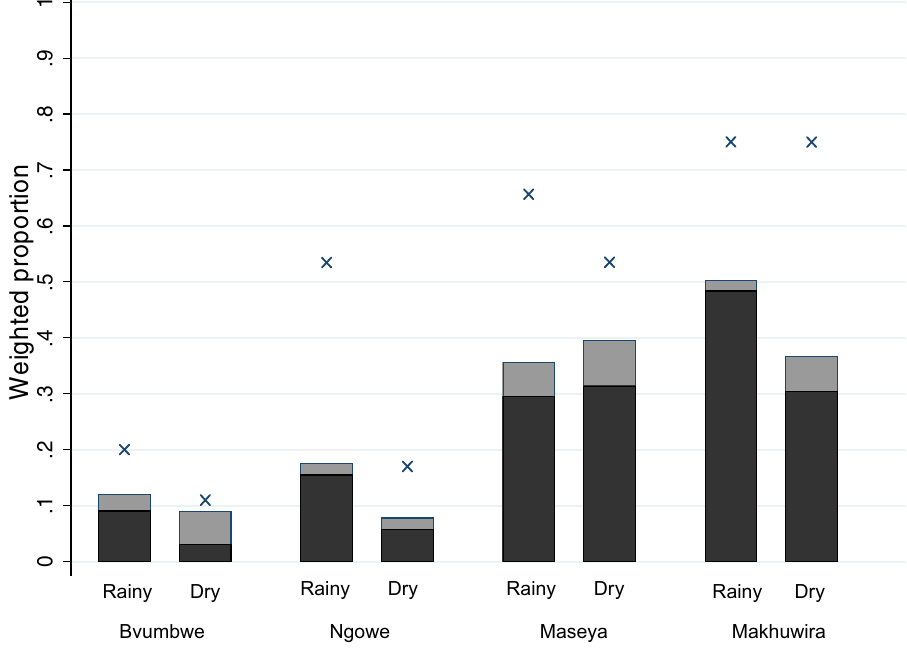
Figure 1. Baseline weighted proportion of students with P. falciparum infection detected by PCR (×) and the weighted proportion of students with gametocyte-containing infections detected (black bar) and not detected (grey bar) by rapid diagnostic test in school-based